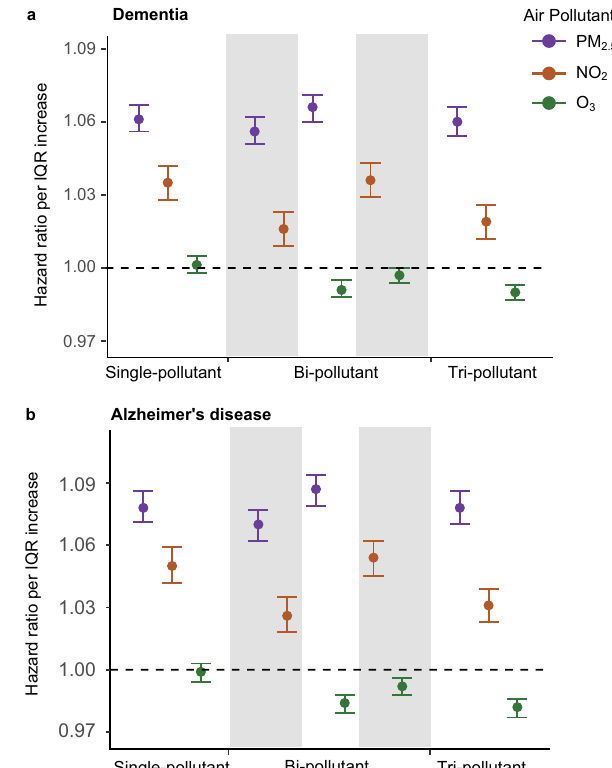
Fig. 2 Results of the Cox proportional hazards models. The two panels present the hazard ratios of a dementia ( n = 12,233,371 individuals examined) or b Alzheimer ’ s disease (AD, n = 12,456,447 individuals examined) associated with per IQR increase in annual PM 2.5 , or annual NO 2 , or warm-season O 3 concentration, respectively. The estimated hazard ratios were obtained using single pollutant, bi-pollutant, and tri-pollutant models. Error bars stand for the 95% con fi dence intervals. The gray and white stripes are used to distinguish any two adjacent models. Source data are provided as a Source Data fi